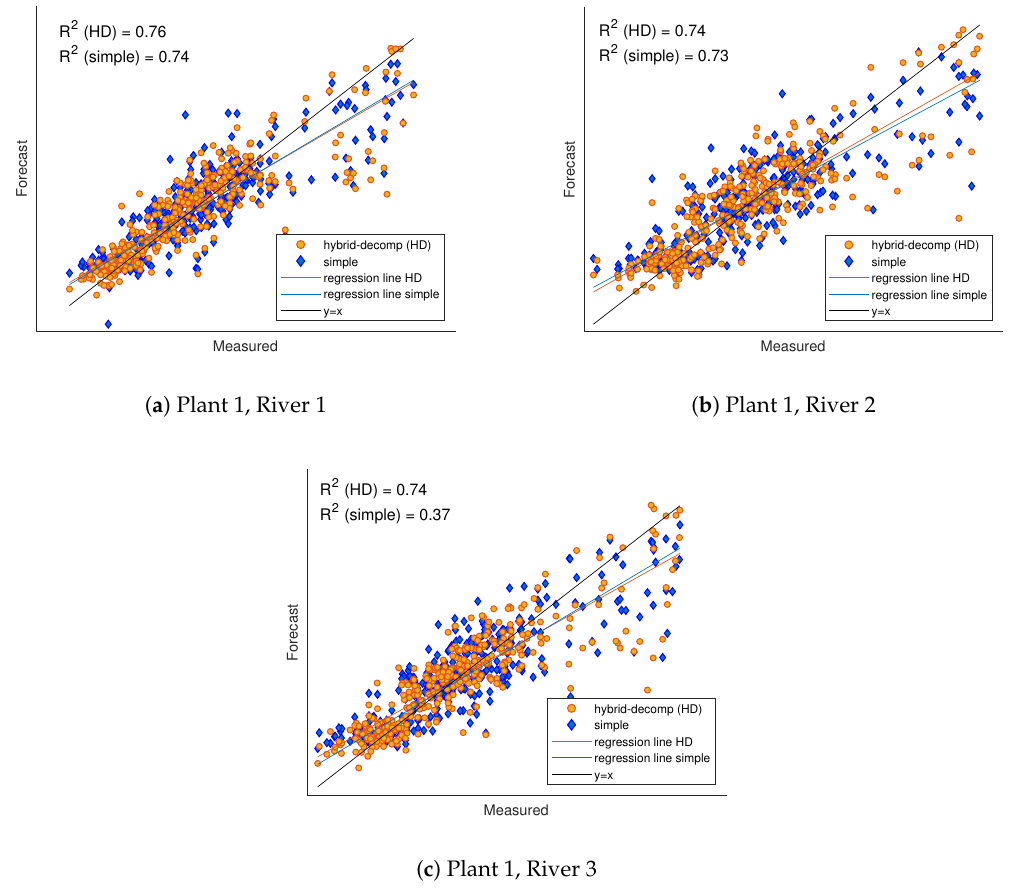
Figure 10. Scatterplot comparison, obtained with real data on x-axis and forecast data on y-axis. In blue the results got with the hybrid decomposition approach, in orange the results with the ANN model for three of the considered plants: ( a ) Plant 1 on river 1; ( b ) Plant 1 on river 2; ( c ) Plant 1 on river